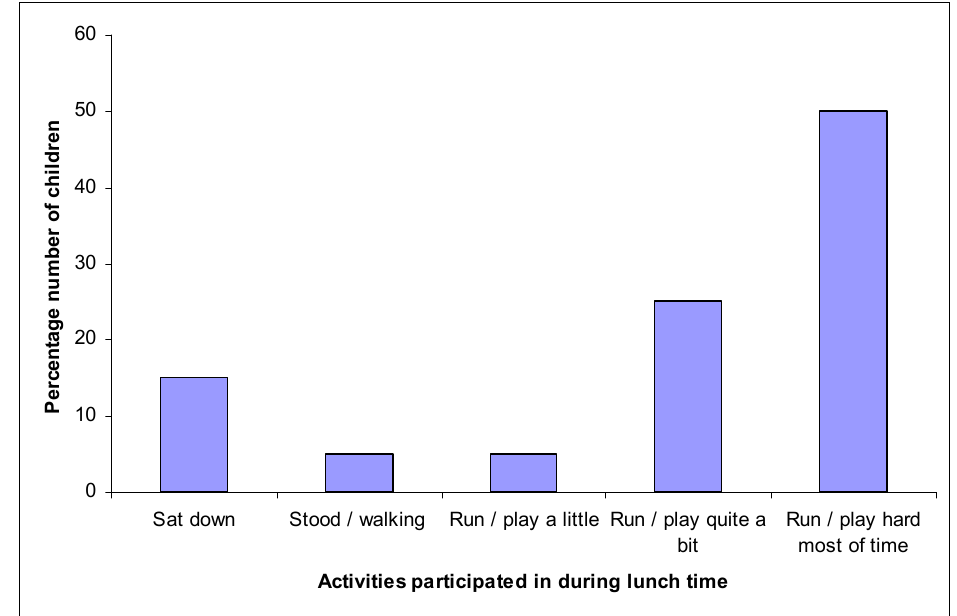
Figure 3. Most popular reported activities reported by children during their lunch time.